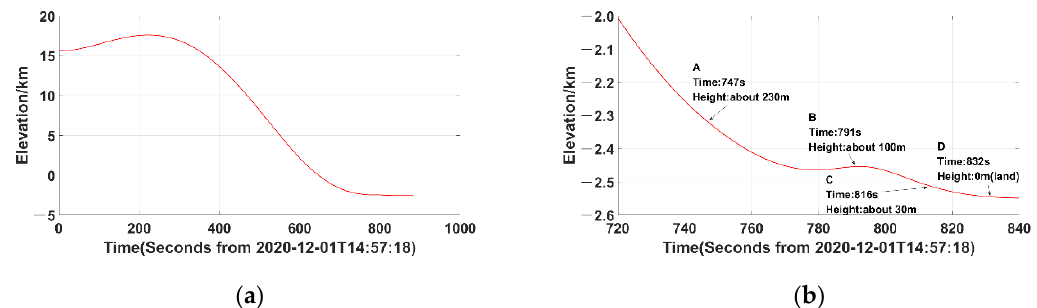
Figure 3. Elevation–time plots in CE-5’s descent trajectory: ( a ) shows that in the whole descent trajectory; ( b ) shows that between 720 s to 840 s after descent has started.